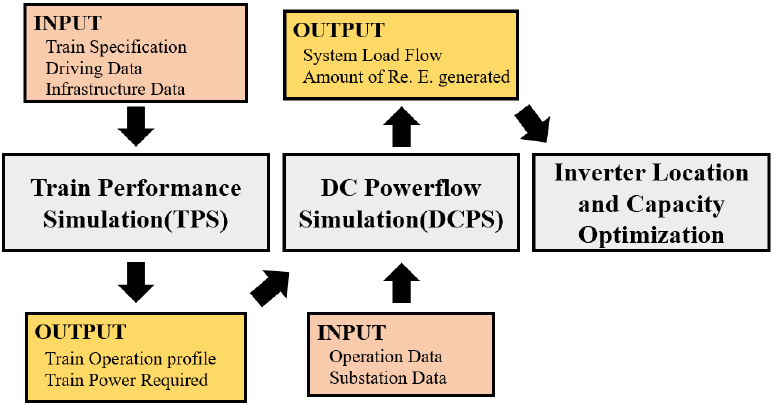
Figure 1. Flowchart of TPS and DCPS.